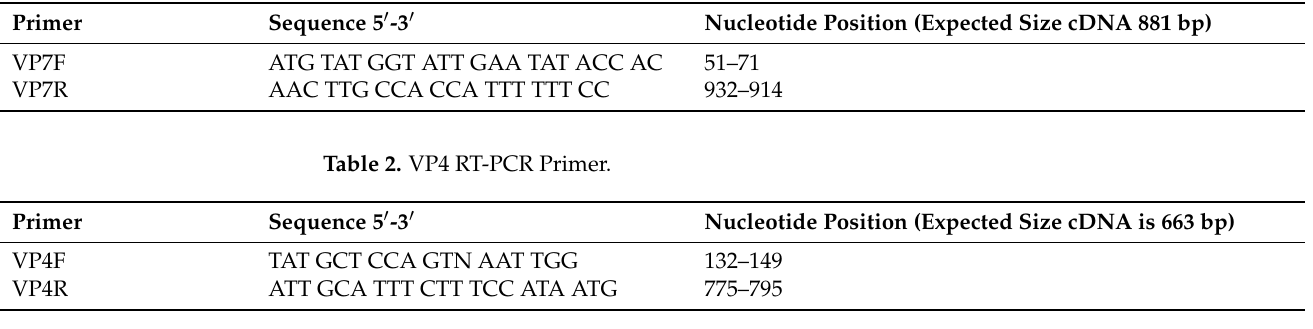
Table 1. VP7 RT-PCR Primer.